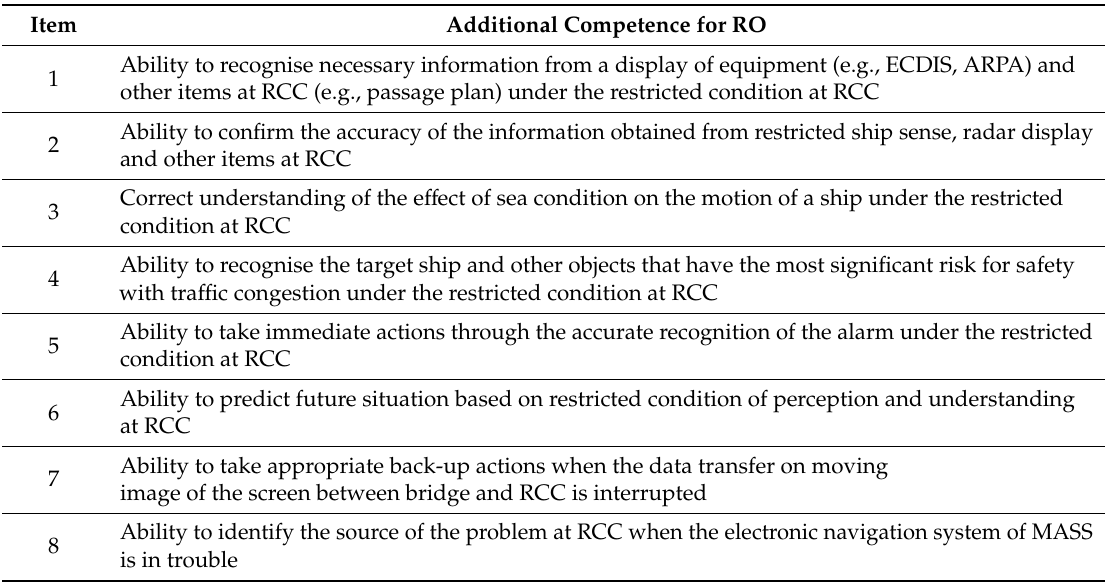
Table 10. Proposed additional competence for RO.